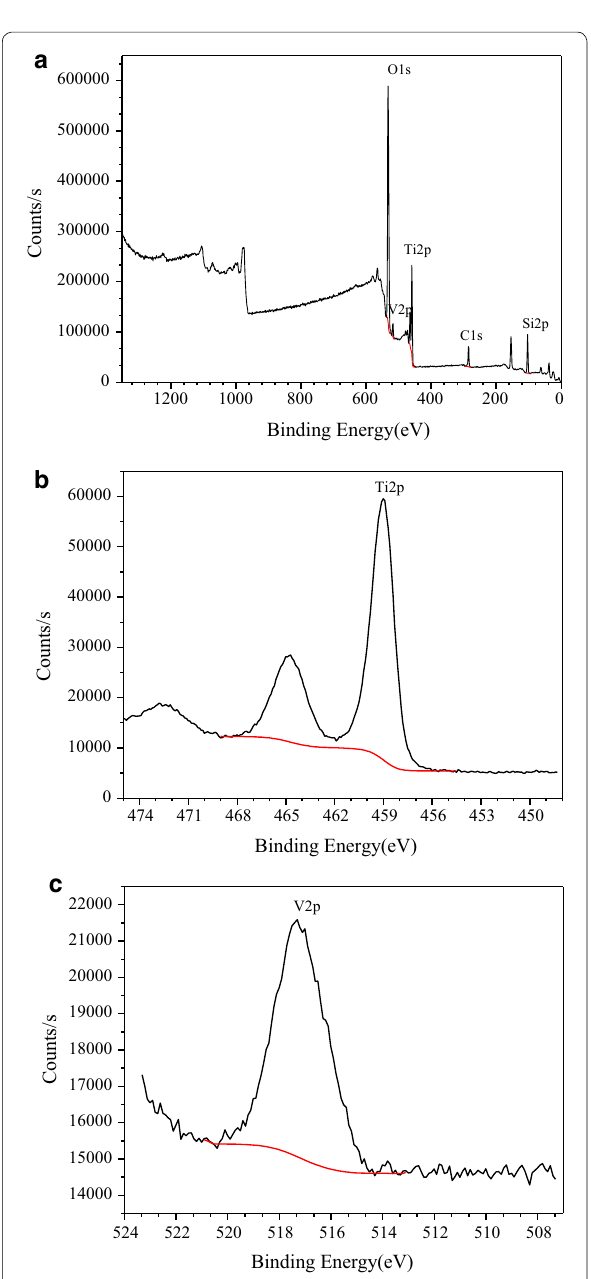
Fig. 7 XPS spectra of 20%Ti-5%V-MCM-41 for the catalyst ( a ); XPS spectra of 20%Ti-5%V-MCM-41 for the catalyst ( b ); XPS spectra of 20%Ti-5%V-MCM-41 for the catalyst ( c )